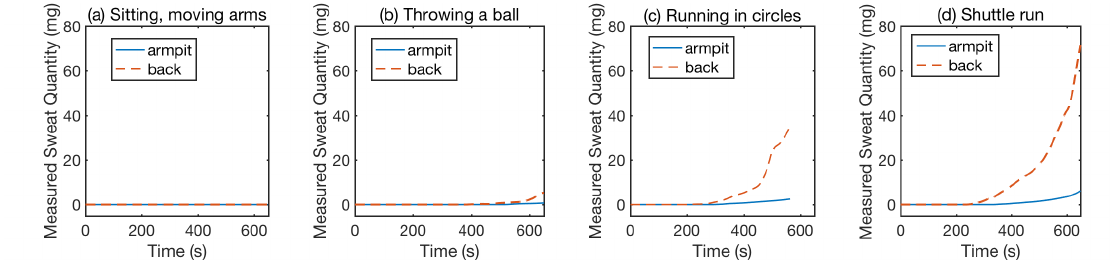
Figure 16. Measured sweat quantities from sensors at different locations when a person conducts different activities